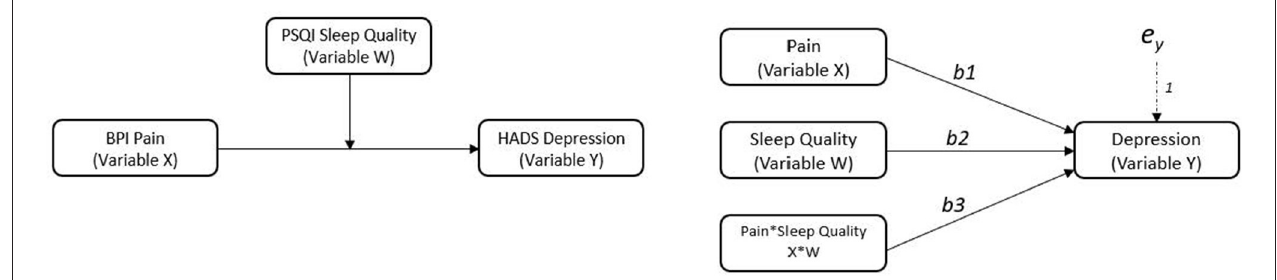
FIGURE 1 | Conceptual and statistical models showing sleep quality as a moderator on the relationship between pain and depression. Variable X is the predictor variable, variable W is the moderator, variable Y is the outcome.